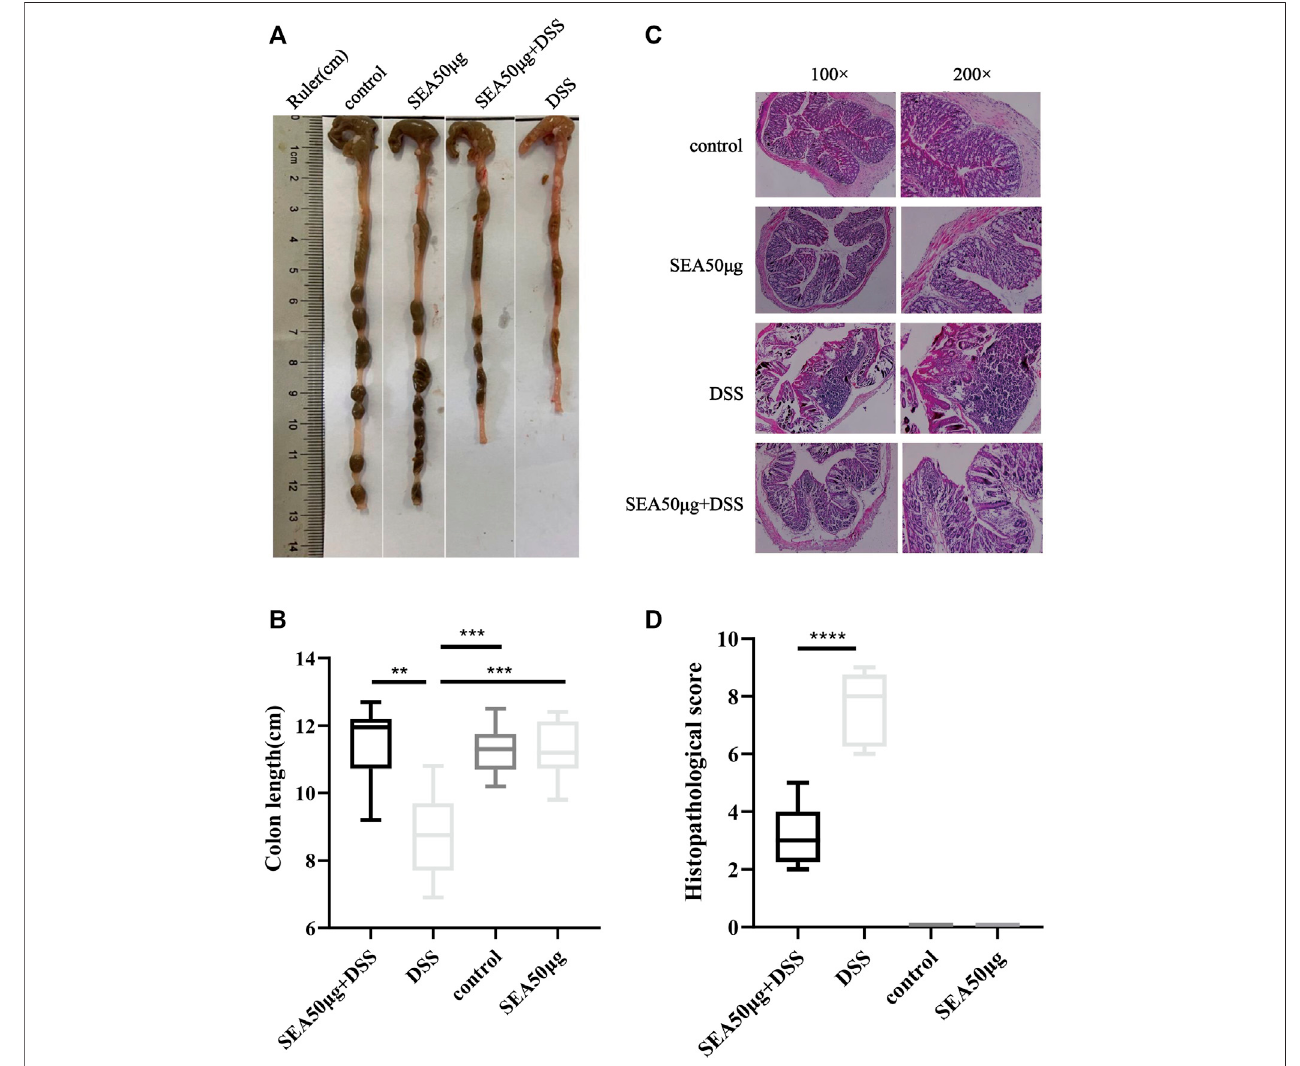
FIGURE 2 | SEA improved DSS-induced colonic symptoms in IBD (A) Colonic status of mice in the control group, SEA 50 μ g group, DSS group, and DSS + SEA 50 μ ggroupafter10 daysofsubdivision. (B) Colonictissueofmicewasobservedunder themicroscopeafterHE staining. (C) Comparison ofcoloniclengthonthe10th day in the control group, SEA 50 μ g group, DSS group, and DSS + SEA 50 μ g group (D) Histological scores of colon sections in the control group, SEA 50 μ g group, DSS group, and DSS + SEA 50 μ g group.